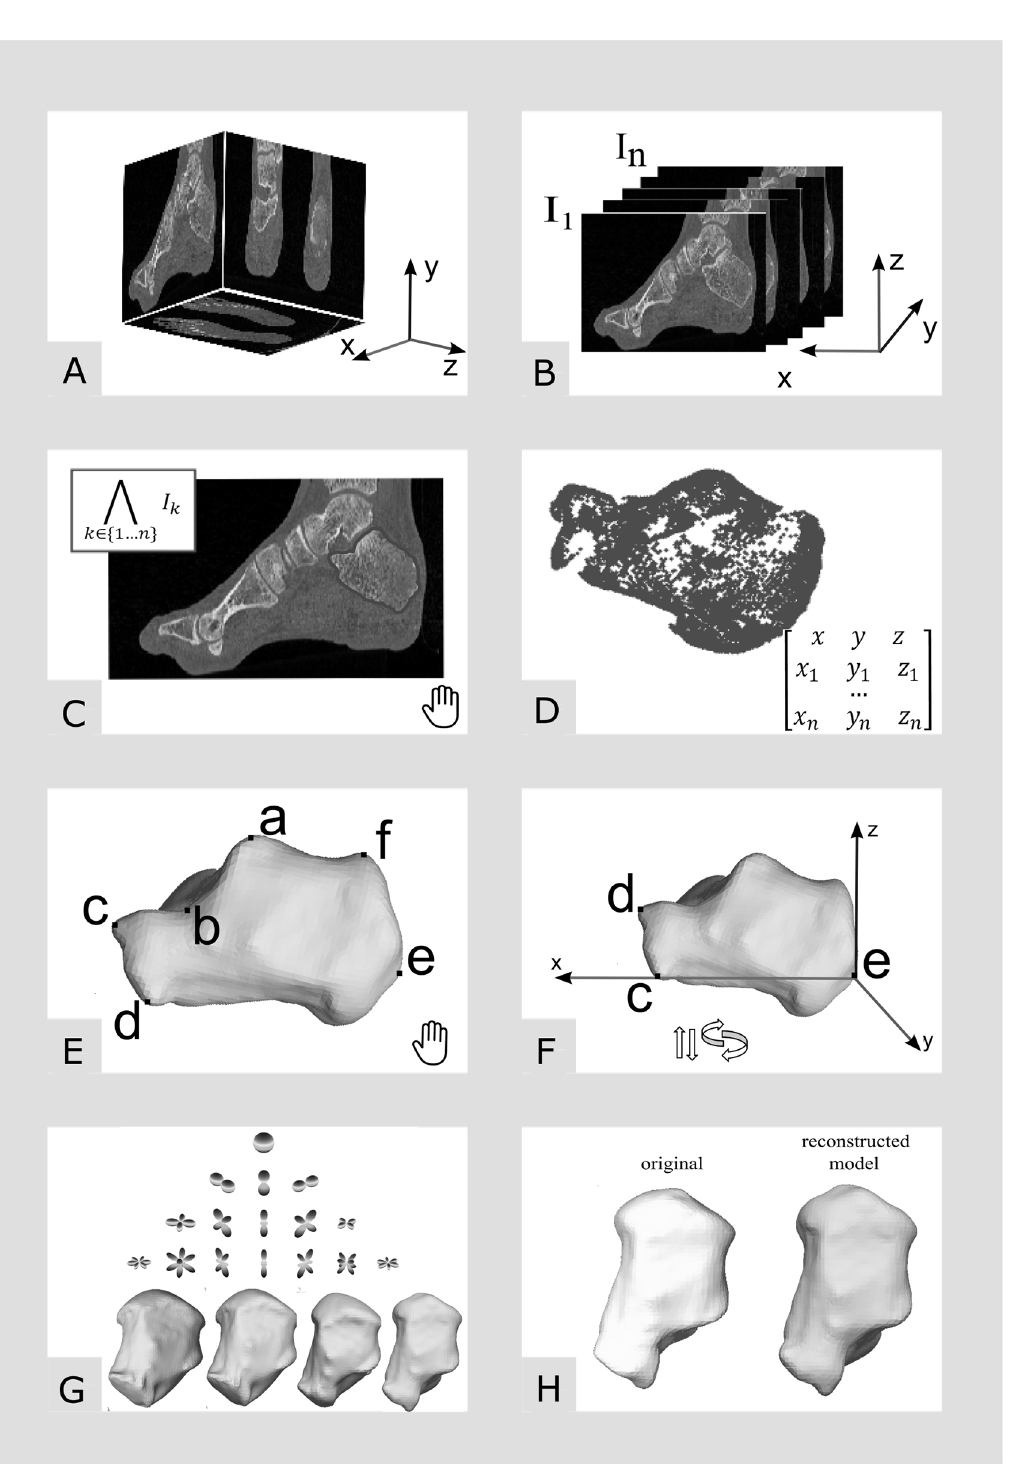
Fig 1. The process of building the morphometric and anatomical atlas of calcaneus. Hand icon denotes manual or semi-manual assisted processing lead by an experienced operator. Arrows icon denotes two isometric operations (translation and rotation) of the shape. Steps A to H are described in detail Section